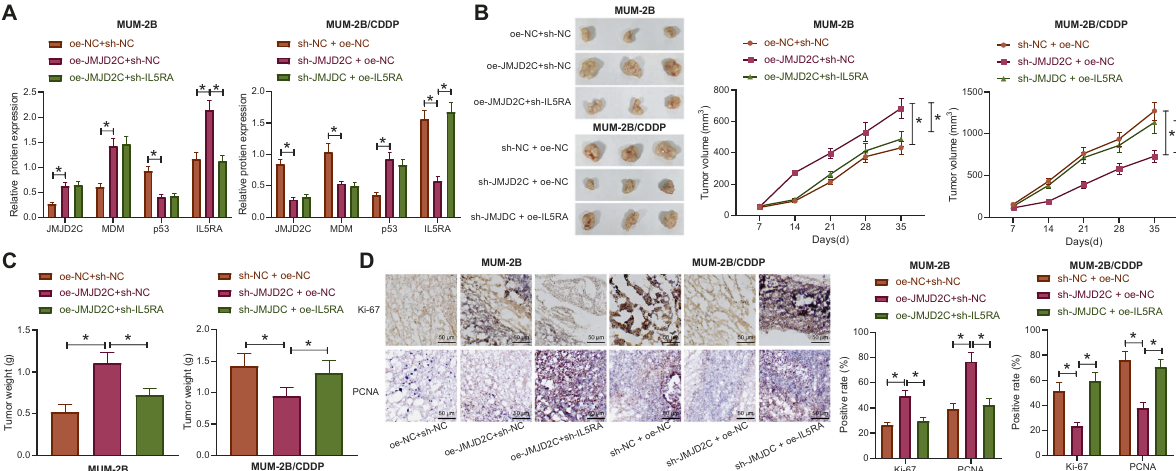
Fig. 6 JMJD2C accelerates the growth of uveal melanoma and increases CDDP resistance in nude mice via regulation of the MDM2/p53/ IL5RA axis. A The expression of JMJD2C, MDM2, p53, and IL5RA in tumors derived from MUM-2B cells and MUM-2B/CDDP cells as measured by Western blot assay. B Representative images showing xenografted tumors in derived from MUM-2B cells and MUM-2B/CDDP cells and tumor growth curves. C The statistical plot for tumor weight of MUM-2B- and MUM-2B/CDDP-implanted nude mice. D Positive rates of Ki67 and PCNA in MUM-2B cell- and MUM-2B/CDDP cell-derived tumor tissues of nude mice as detected by immunohistochemistry. Scale bar = 50 μ m. n = 8 for mice following each treatment. * p <